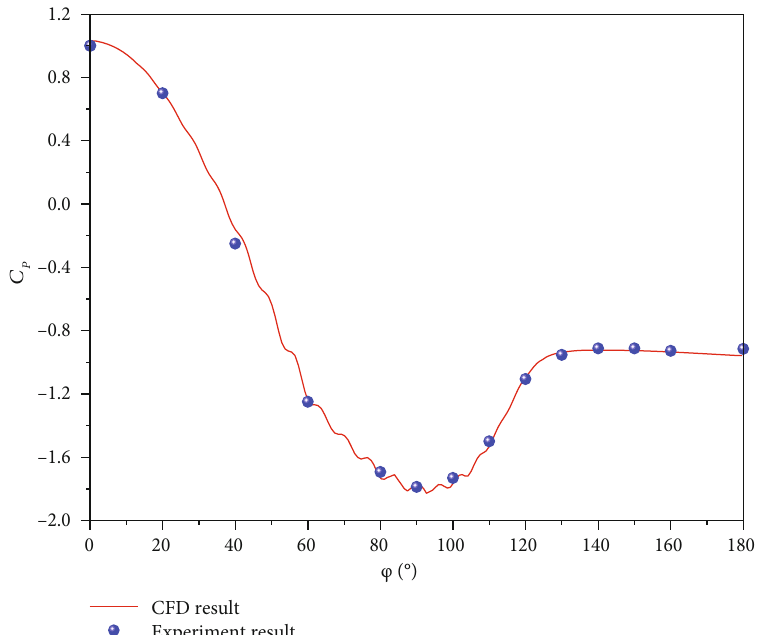
Figure 5: Comparison diagram of numerical simulation results and experimental values of rough cylinder mean pressure coe ffi cient distribution at 15m/s.